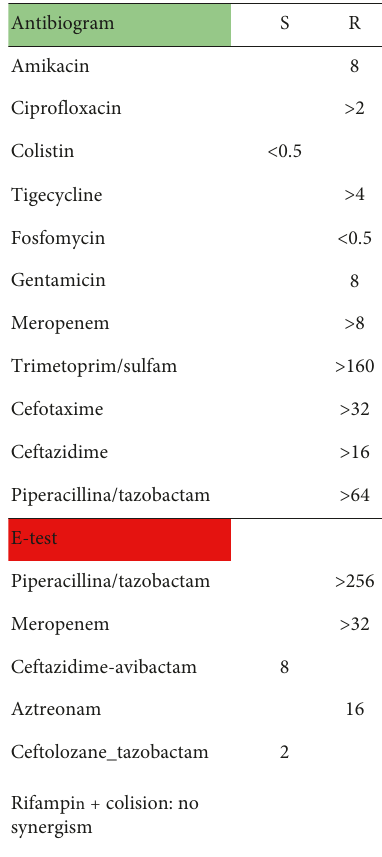
Figure 3: Antibiogram of XDR Pseudomonas .